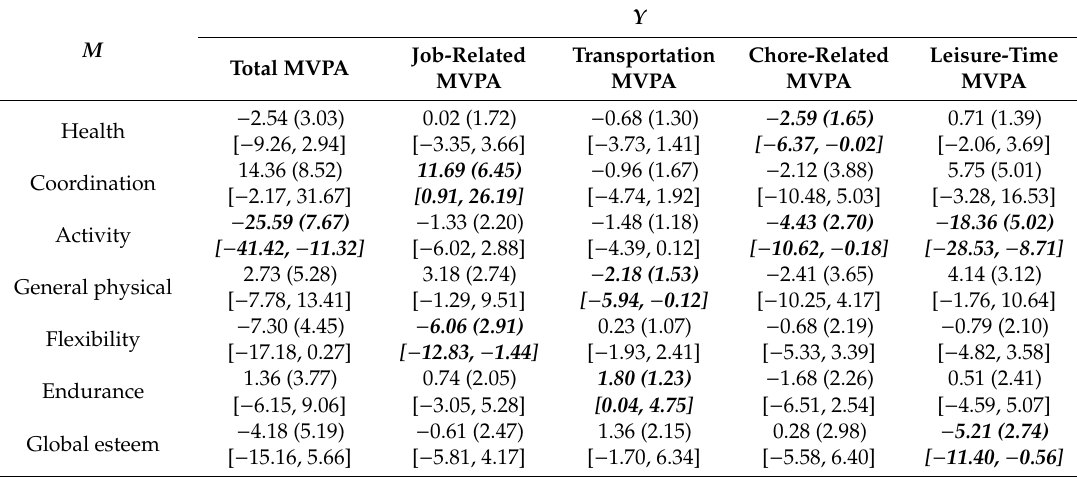
Table 4. The multiple mediating e ff ects of domain-specific